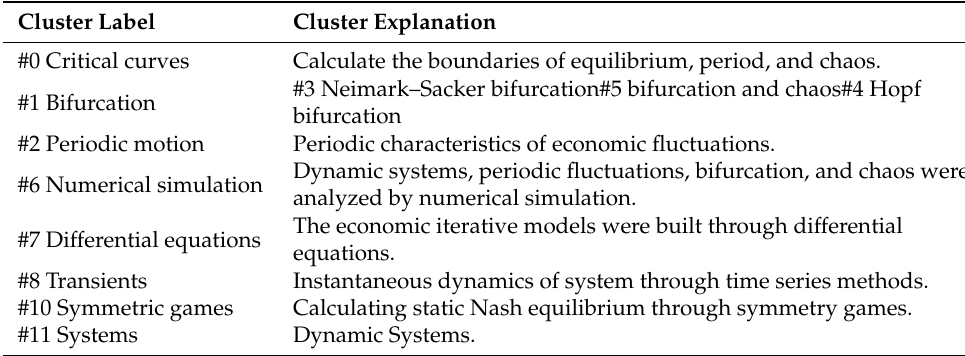
Figure 2. The cluster of keywords. Table 2. Cluster explanation.